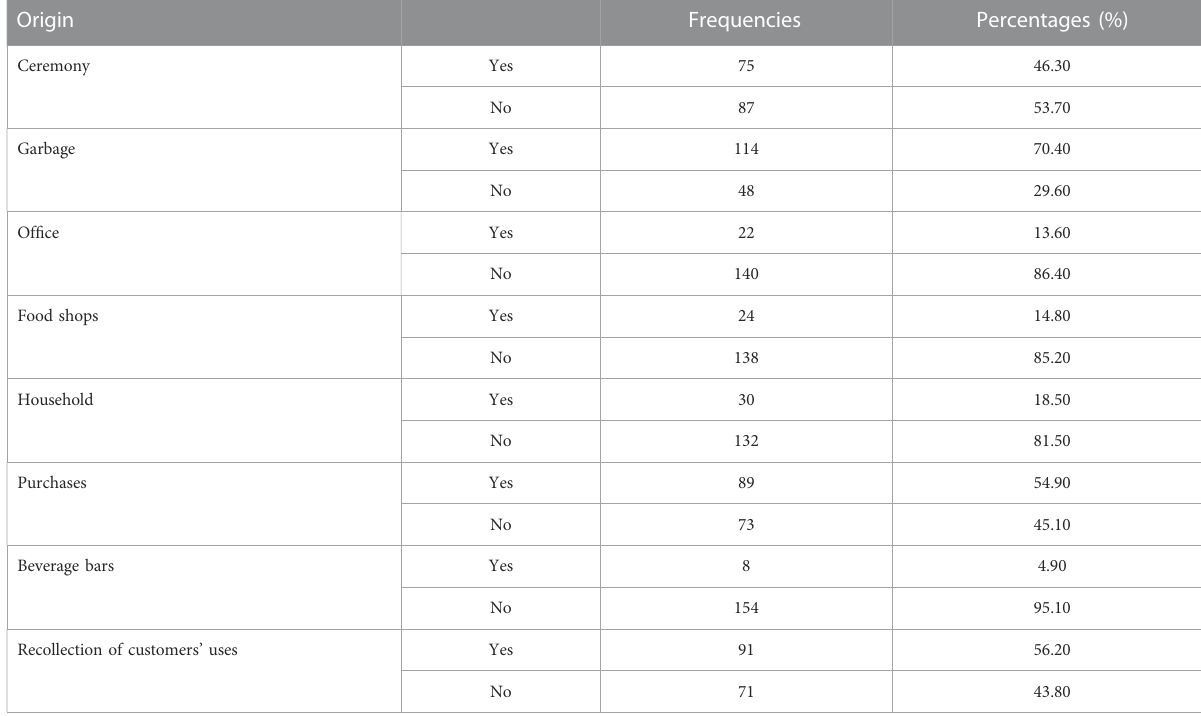
TABLE 2 Origin of bottles used for traditional food